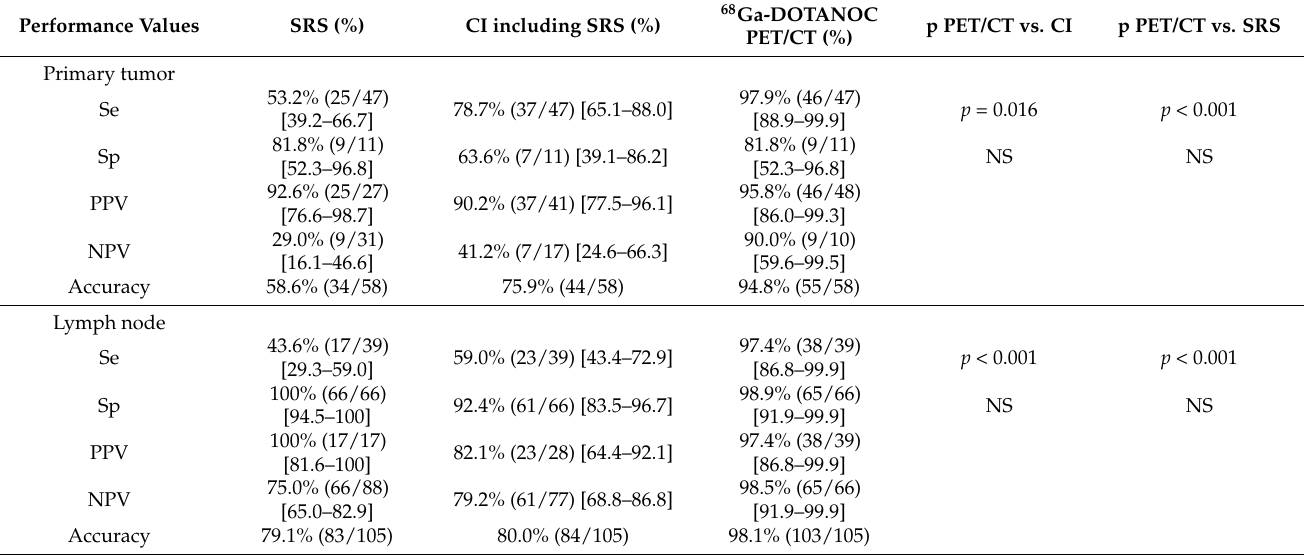
Table 4. Sensitivities, specificities, positive predictive values, negative predictive values and accu- racies of SRS, Conventional Imaging and 68 Ga-DOTANOC PET/CT at primary tumor and lymph nodes’